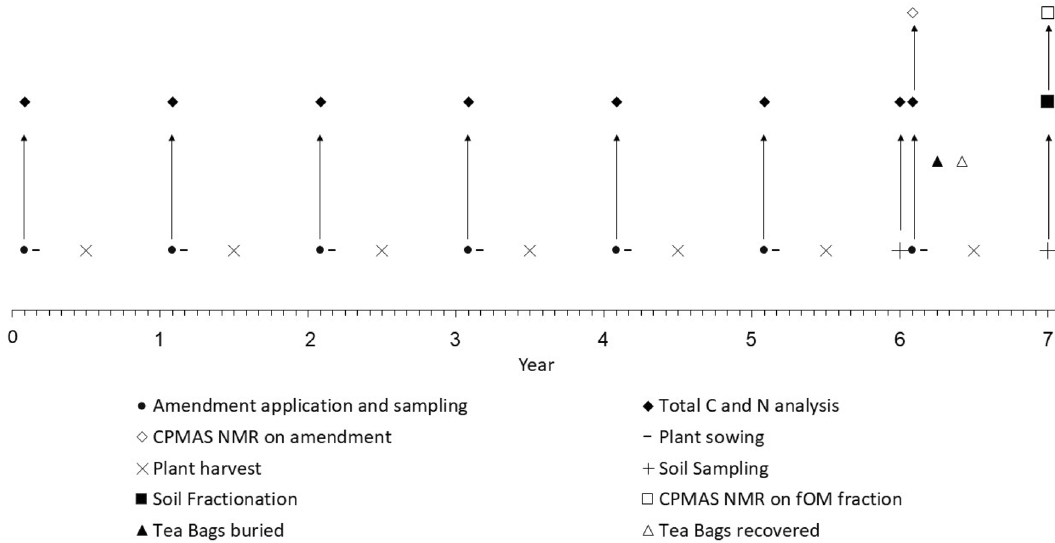
Figure 1. Timeline for sampling and analysis strategy. Plant selections: Year 0—Sunflower ( Helianthus annuus ‘Antonil’); Year 1—Borage ( Borago officinalis ); Year 2—Garden cosmos ( Cosmos bipinnatus ‘Sonata White’); Year 3—Nigella ( Nigella damascene ‘Miss Jekyll’); Year 4—Honeywort ( Cerinthe major ‘Purpurascens’); Year 5— Marigold ( Calendula officinalis ‘Neon’); Year 6—Fiddleneck ( Phacelia tanacetifolia ); Year 7—Mallow ( Lavatera trimestris ‘Ruby